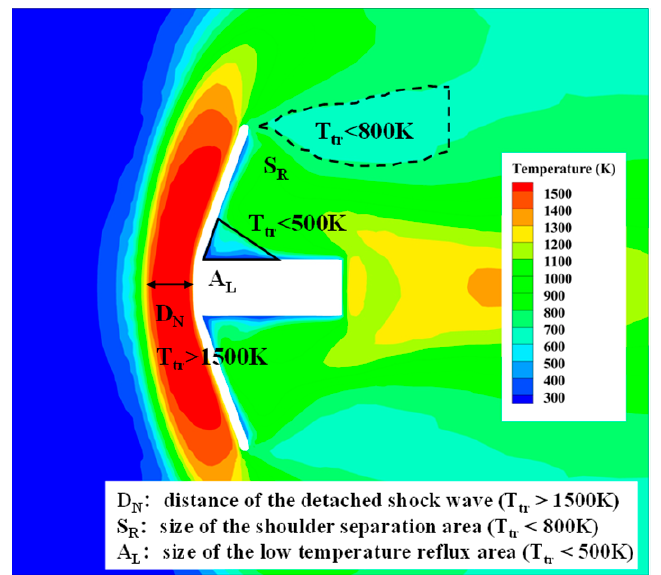
Figure 8. Flow field structure characteristic Figure 8. Flow fi eld structure characteristic parameters.